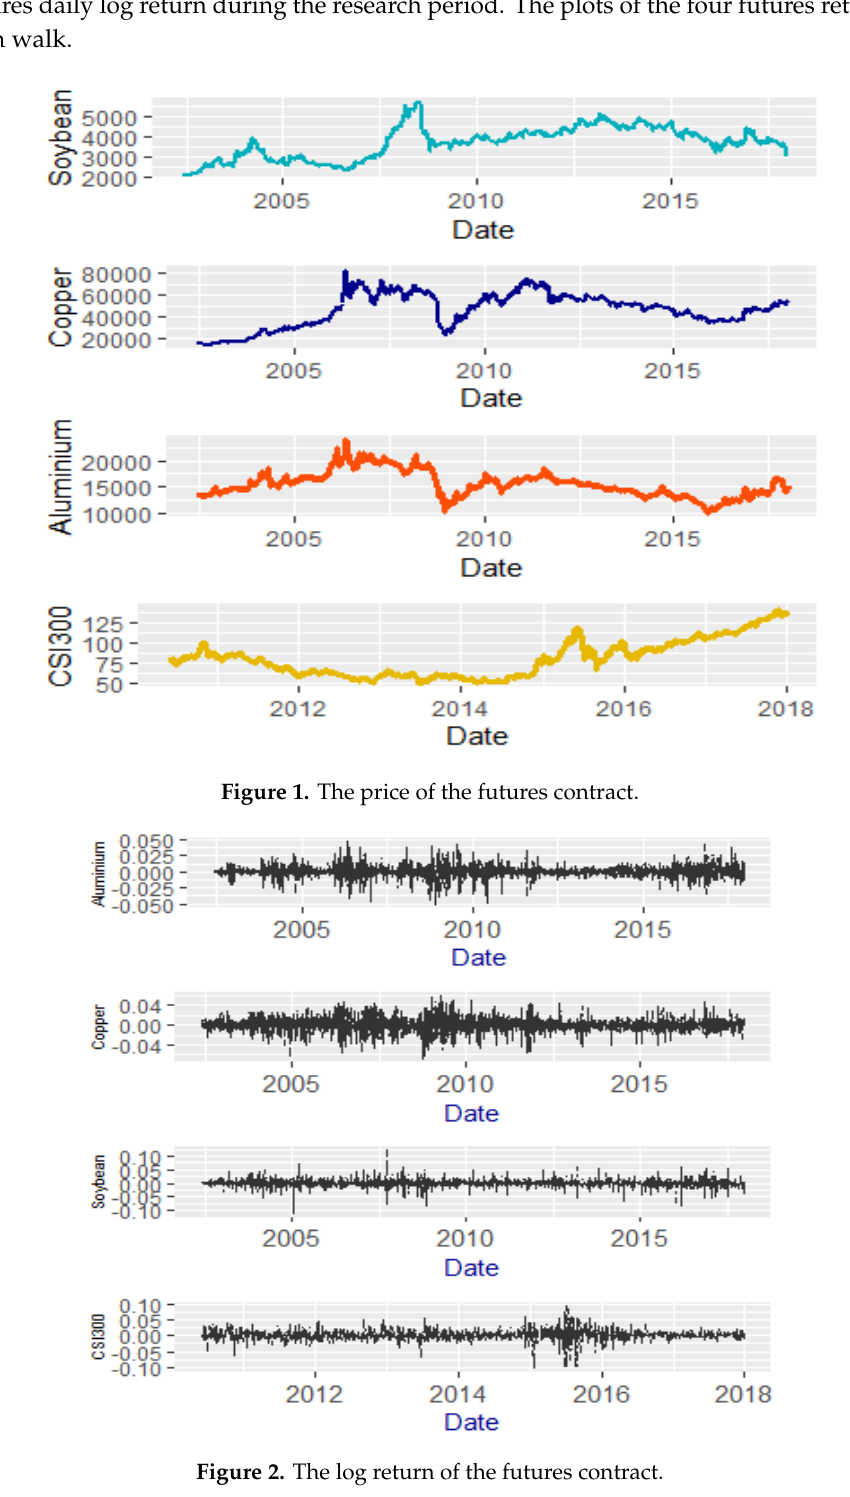
Figure 2. The log return of the futures contract.